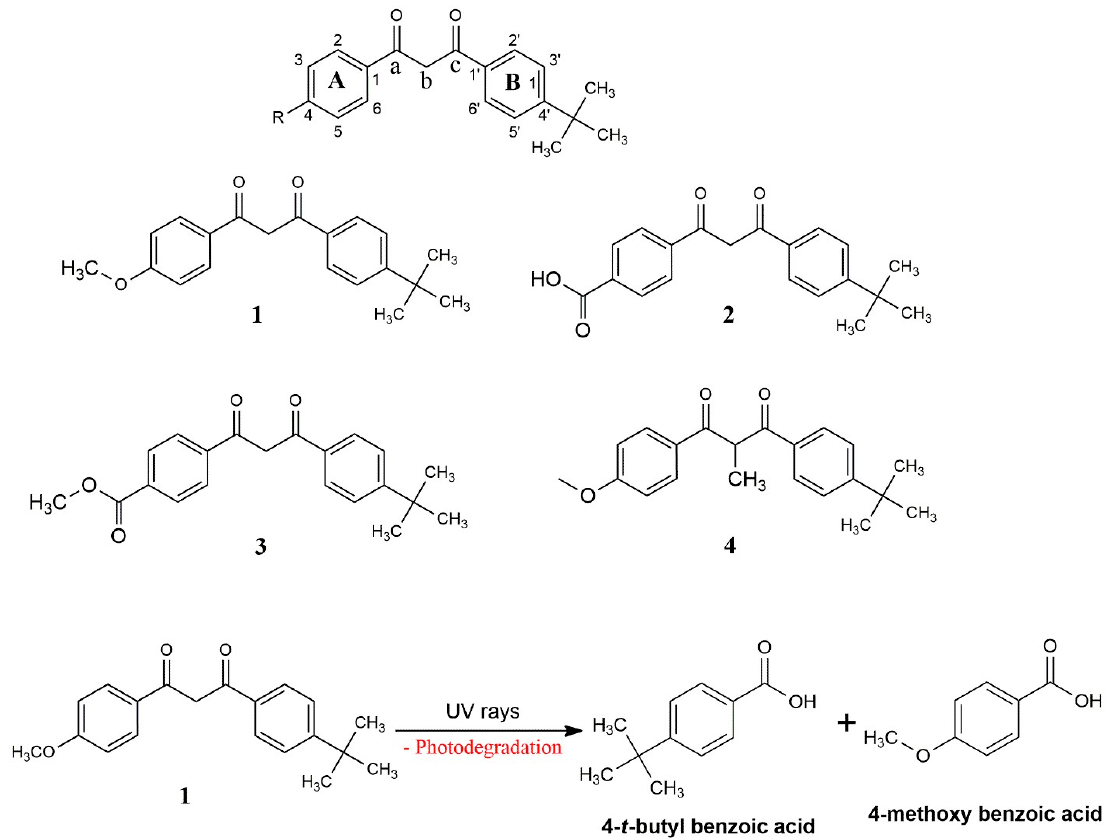
Figure 3. Structure-activity relationship and photodegradation of avobenzone: The substitution of the R group on ring ‘A’ of avobenzone with electron-withdrawing groups increases the photostability, while electron-donating groups destabilize it (entries 1, 2 and 3). Furthermore, blocking the keto-enol tautomerism by replacing the acidic hydrogen with the methyl group also contributes positively to the photostability of avobenzone (entry 4). Avobenzone degrades into 4-t-butyl benzoic acid and 4-methoxy benzoic acid